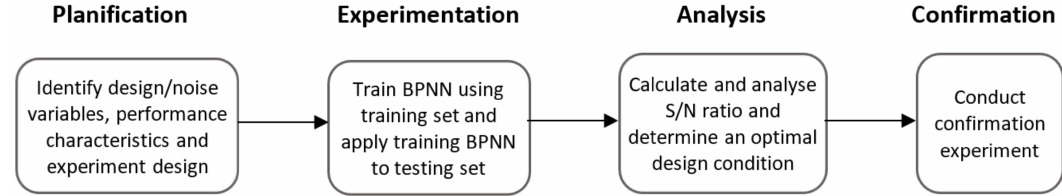
Figure 5. Robust design methodology for the optimization of structural